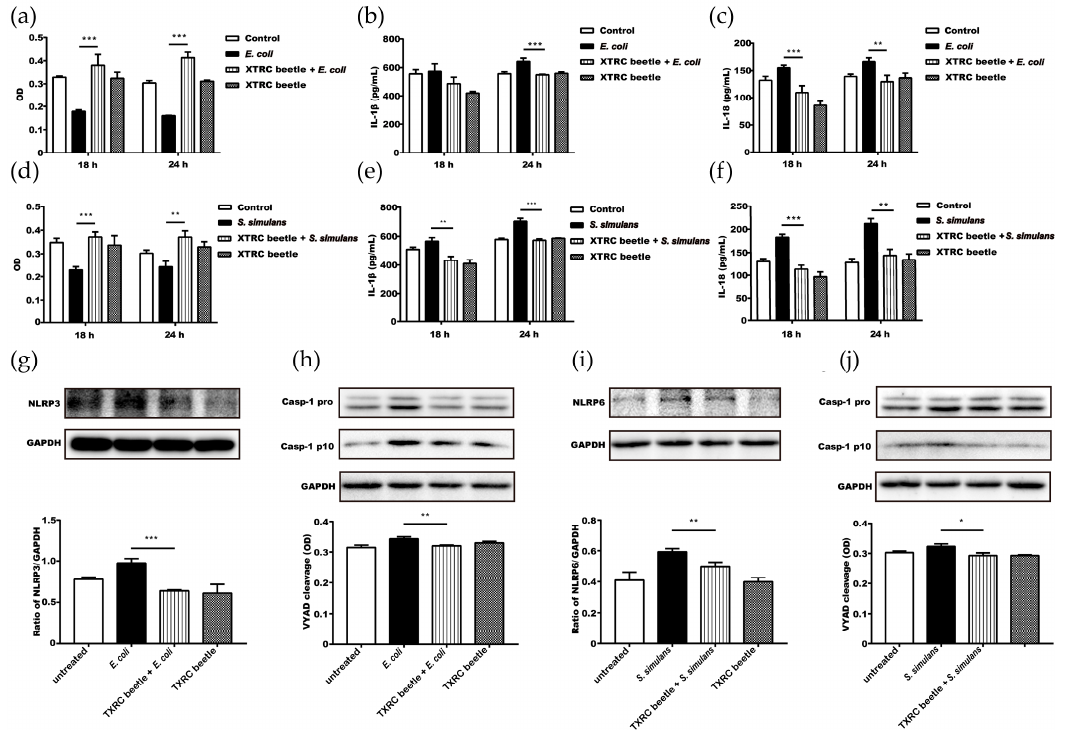
Figure 5. Z. morio hemolymph inhibits bacteria-induced NLRP3 and inflammasome activation. ( a ) MAC-T cells (5000 cells / well) were either untreated; treated alone with E. coli (5 × 10 5 CFU) ; treated with Z. morio hemolymph (2 mg / mL) and E. coli (5 × 10 5 CFU); treated alone with Z. morio hemolymph (2 mg / mL). 18 or 24 h after stimulation, cells were washed with PBS and cultured in DMEM supplemented with 2% FBS and 10 µ L of enhanced CCK-8 solution. After 2 h of culture, OD 450 was measured. ( b ) MAC-T cells (3 × 10 5 cells / well) were either untreated; treated alone with E. coli (3 × 10 7 CFU) ; treated with Z. morio hemolymph (2 mg / mL) and E. coli (3 × 10 7 CFU); treated alone with Z. morio hemolymph (2 mg / mL). 18 or 24 h after stimulation, supernatants were collected for detecting the concentration of IL-1 β . ( c ) Similar to ( b ), except the supernatants were collected for detecting the concentration of IL-18. ( d ) MAC-T cells (5000 cells / well) were either untreated; treated alone with S. simulans (5 × 10 5 CFU) ; treated with Z. morio hemolymph (4 mg / mL) and S. simulans (5 × 10 5 CFU); treated alone with Z. morio hemolymph (4 mg / mL). 18 or 24 h after stimulation, cells were washed with PBS and cultured in DMEM supplemented with 2% FBS and 10 µ L of enhanced CCK-8 solution. After 2 h of culture, OD 450 was measured. ( e ) MAC-T cells (3 × 10 5 cells / well) were either untreated; treated alone with S. simulans (3 × 10 7 CFU) ; treated with Z. morio hemolymph (4 mg / mL) and S. simulans (3 × 10 7 CFU); treated alone with Z. morio hemolymph (4 mg / mL). 18 or 24 h after stimulation, supernatants were collected for detecting the concentration of IL-1 β . ( f ) Similar to ( e ), except the supernatants were collected for detecting the concentration of IL-18. ( g ) Similar to ( b ), except that 8 h after challenging, the whole cell lysis was used for detecting the NLRP3. ( h ) Similar to ( b